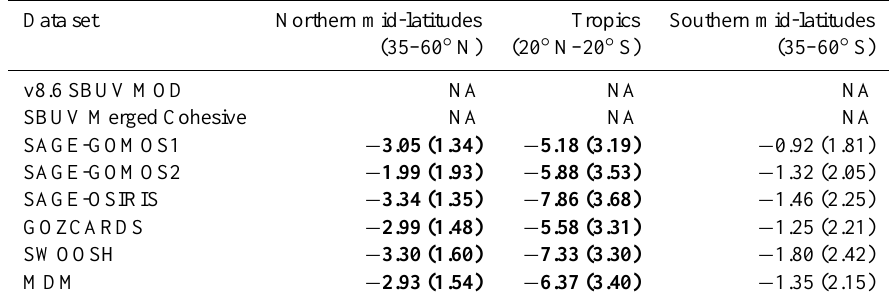
Table 10. As for Table 8 but for 50hPa. Trends were not calculated for the SBUV data sets at pressures greater than 20 and 30hPa in the tropics and mid-latitudes, respectively; therefore they are not shown